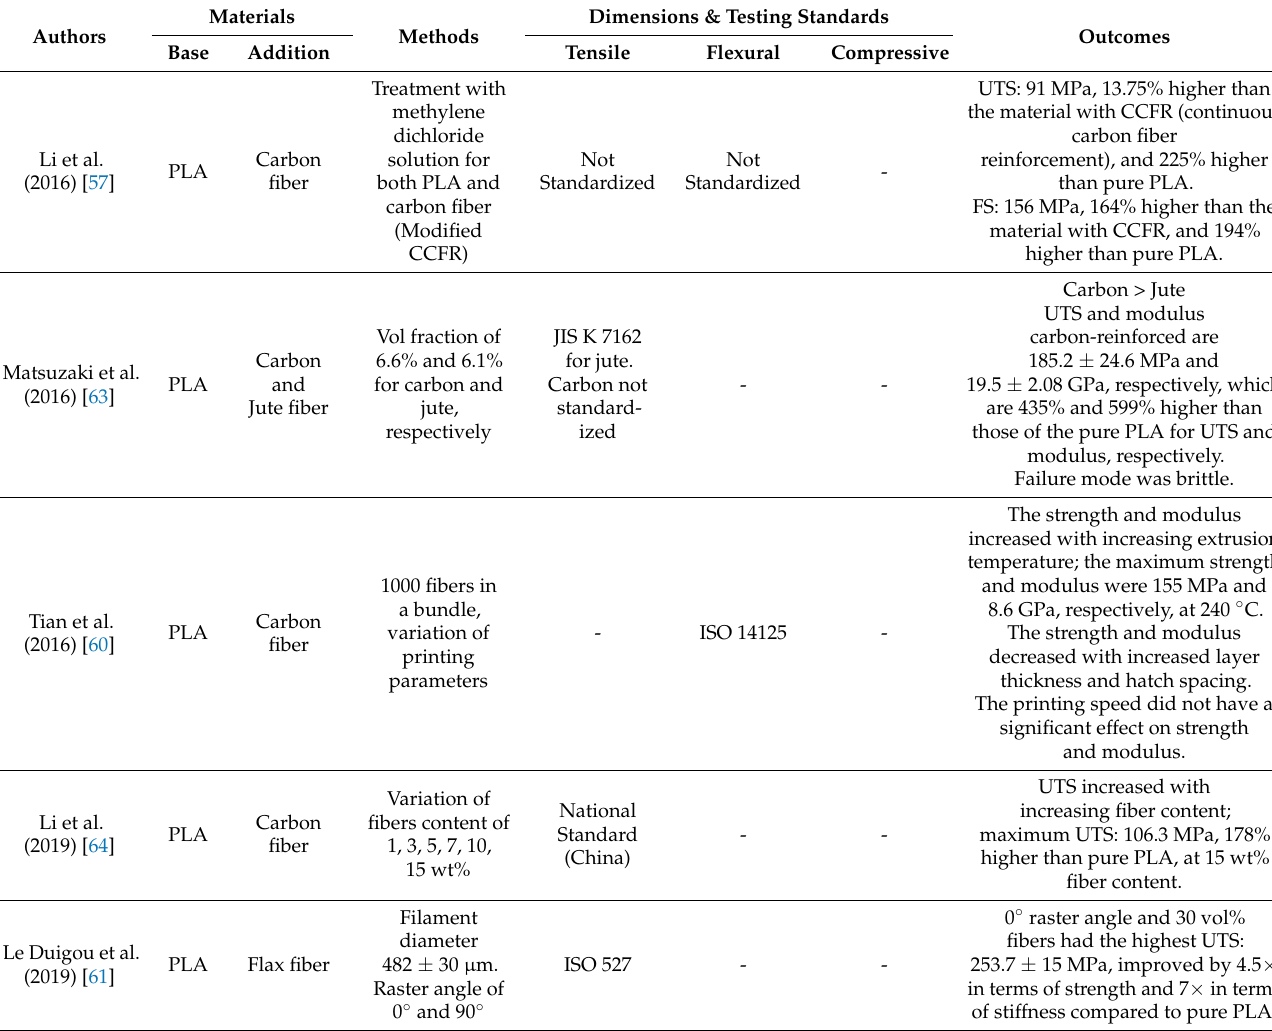
Figure 7. FFF process with the CFR method. Reprinted with permission from [60]. Copyright 2016, Elsevier. Table 3. Research on Continuous Fiber